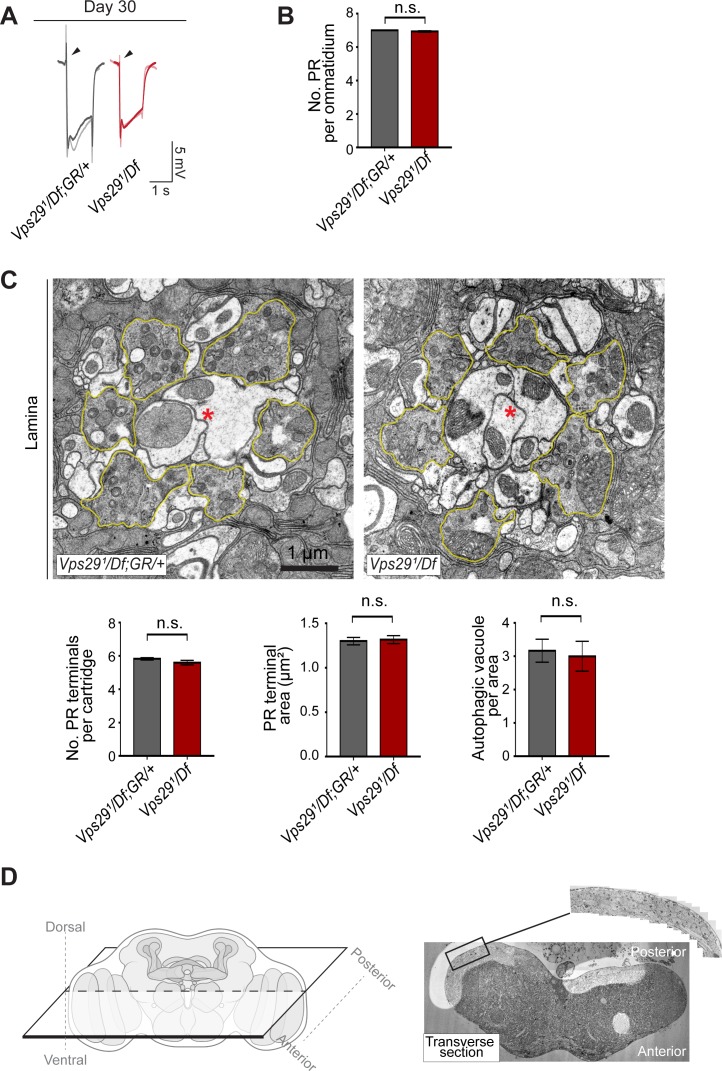
Additional ultrastructural analysis of Vps29 mutants.(A) Electroretinogram (ERG) traces of Vps291/Df and Vps291/Df; GR/+ prior to transmission electron microscopy (TEM). Flies were raised under ambient light conditions (~500 lux) for 30 days. Representative traces for n = 2 animals are superimposed for each genotype. (B) Photoreceptor (PR) numbers are preserved in 30-day-old Vps291/Df animals, based on counts from retinal TEM. Quantification based on examination of n = 30 ommatidia (three independent animals) for each genotype. (C) In 30-day-old Vps29 mutants, no overt ultrastructural defects are detected in the lamina, which contains PR presynaptic terminals (yellow outline). Dendritic processes (postsynaptic) are indicated with red asterisks. Quantification based on examination of n = 30 cartridges (three independent animals) for each genotype. No changes were noted in either the number or area of PR terminals or the number of autophagic vacuoles. (D) Left: schematic showing orientation for thin sectioning prior to TEM analysis of fly brain. Right: Representative transverse section of fly brain at low magnification. Boxed region of interest (magnified inset) highlights the dorsal-posterior cortical region with densely packed neuronal cell bodies. This region was imaged at higher magnification in Figure 7D. Statistical analysis (B, C) based on Student’s t-test. All error bars denote SEM. n.s., not significant.